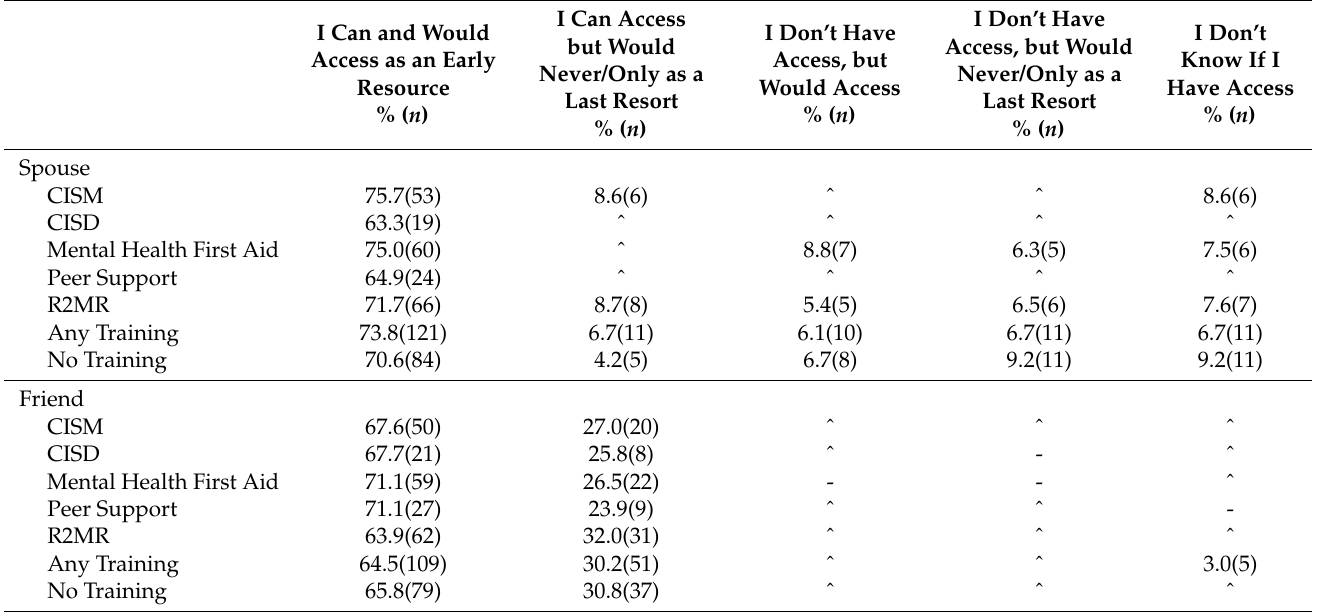
Table 2. Prevalence of mental health training categories and attitudes toward accessing non- profes- sional mental health